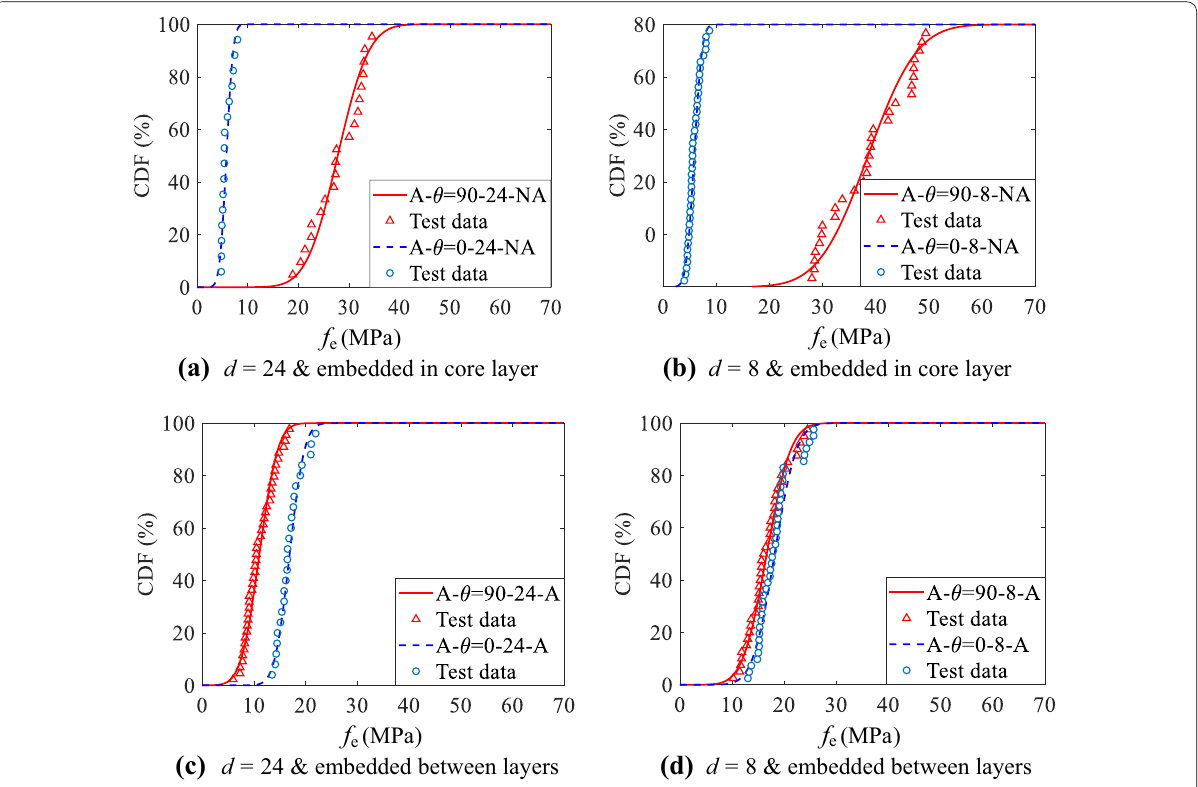
Fig. 13 Embedment strength of dowels under different loading